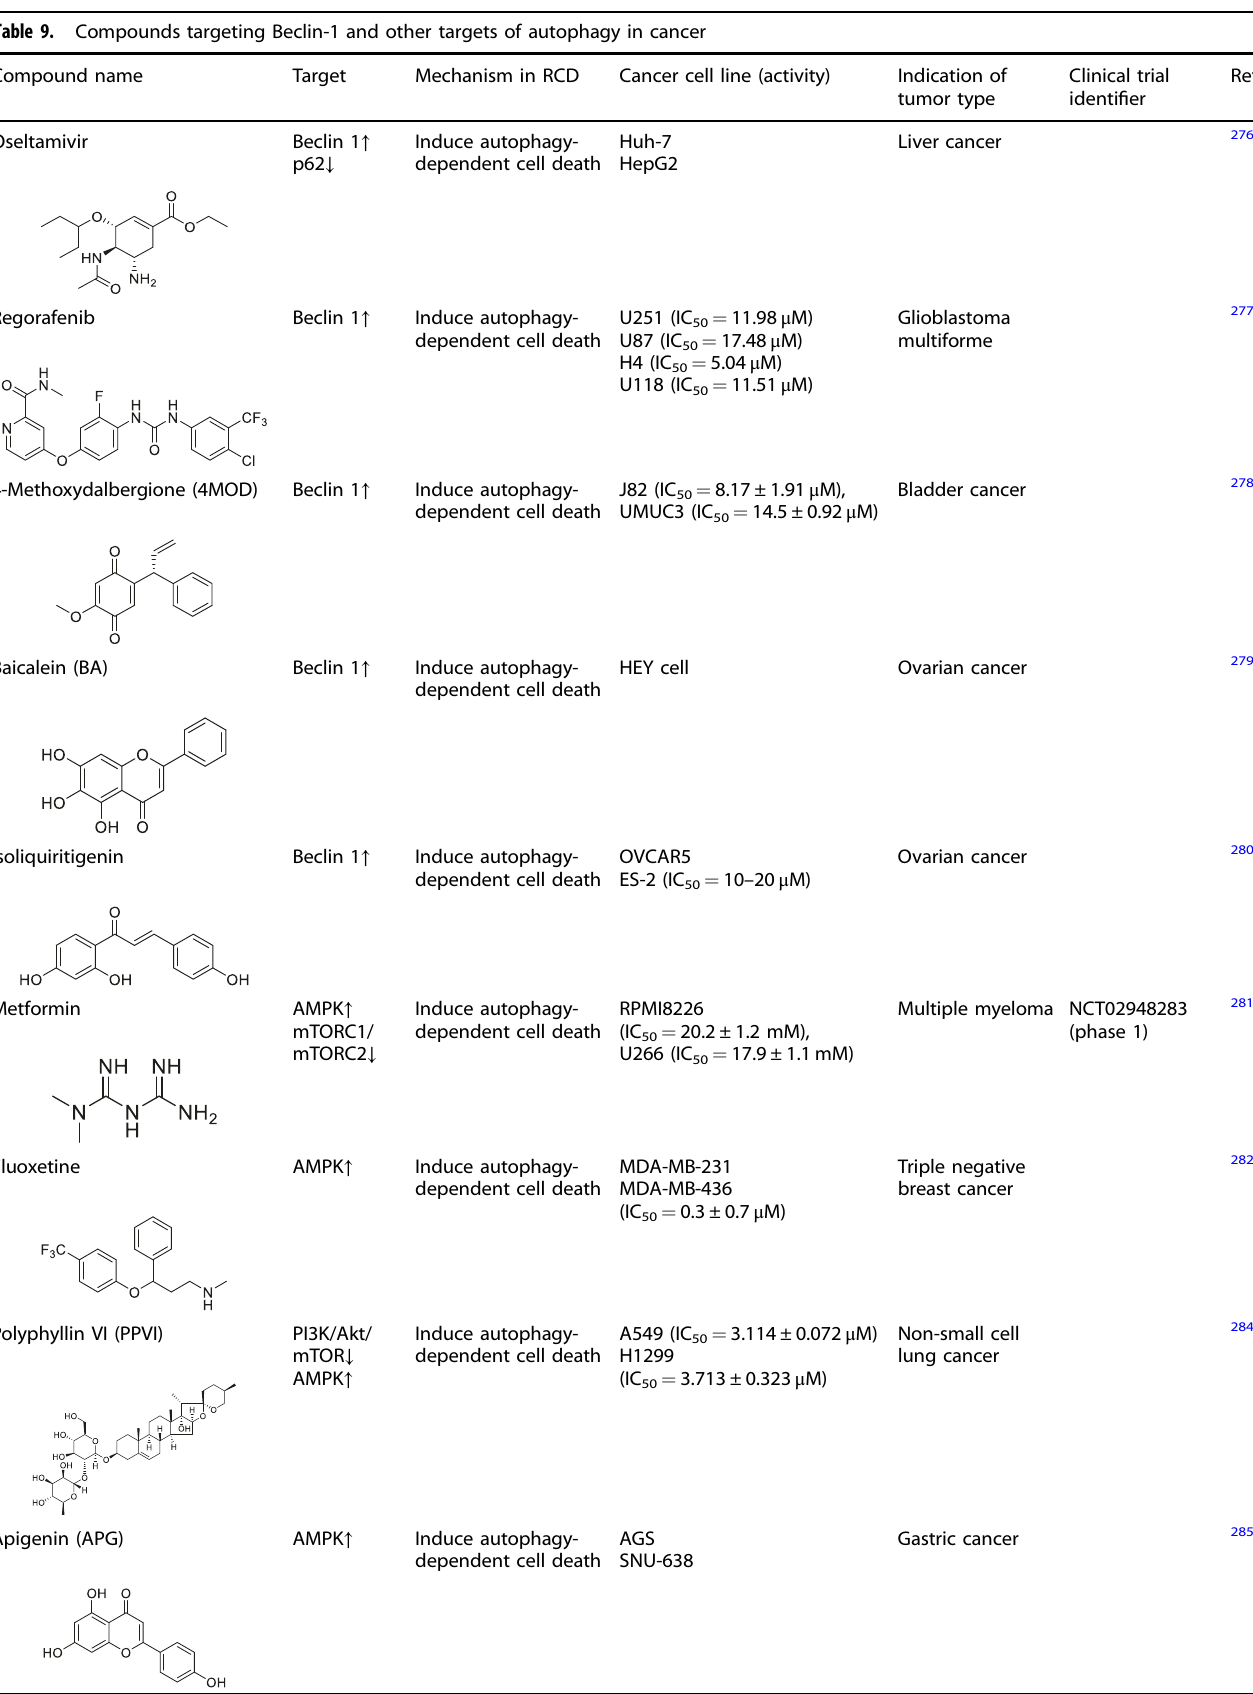
Table 9. Compounds targeting Beclin-1 and other targets of autophagy in